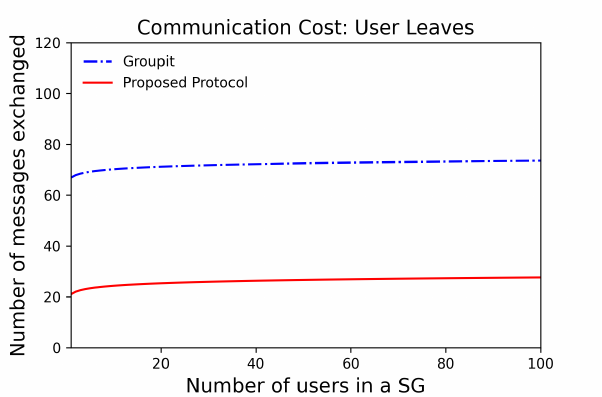
Figure 13. The figure shows the total computational load for all devices under GroupIt and the proposed protocol versus the number of devices in a DG for the case when a new user